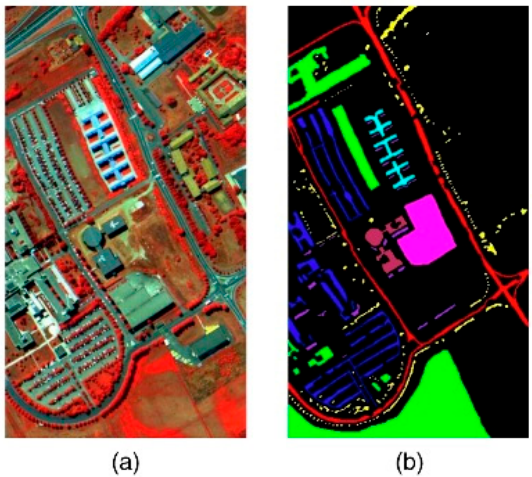
Figure 5. The Pavia dataset: ( a ) a false color composite image and ( b ) the ground truth.